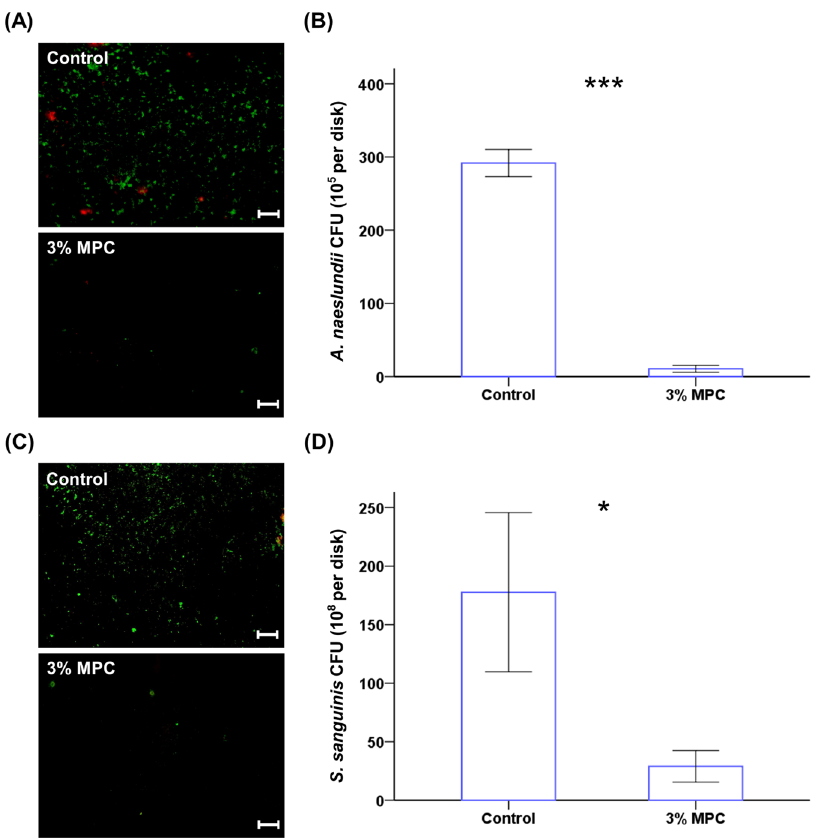
Figure 4. Representative live/dead staining images of A. naeslundii ( A ) and S. sanguinis ( C ) cells attached on the surfaces of control and 3% MPC-LCFV. Scale bar is 100 µ m. CFU counts derived from A. naeslundii ( B ) and S. sanguinis ( D ) cells attached on the surfaces of control and 3% MPC-LCFV. * P < 0.05, *** P < 0.001 for comparisons between LCFV with 3%